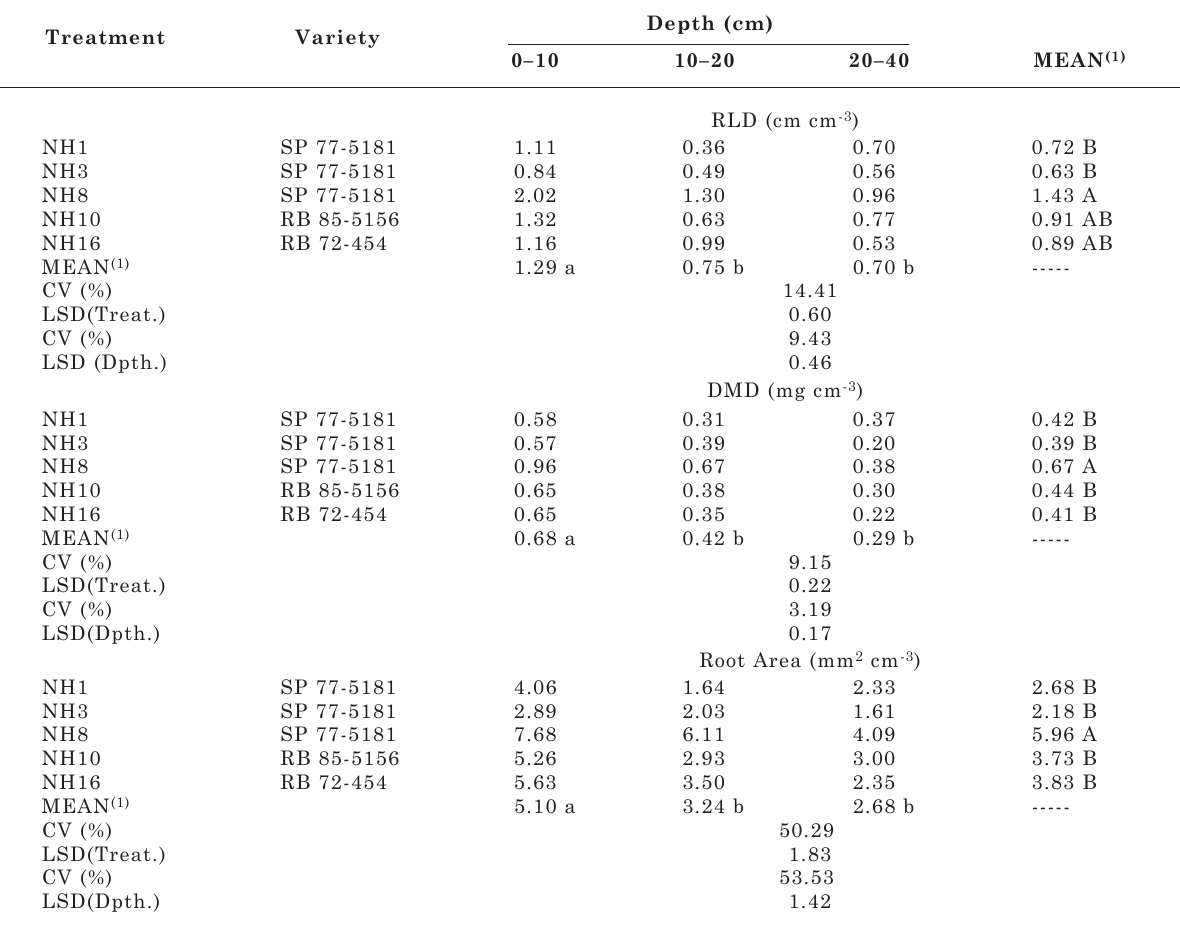
table 3. Values for root length density (rld), dry mass density (dMd) and root area at three depths in eutroferric red oxisol (latossolo Vermelho eutroférrico) after varying periods of sugarcane (number of harvests -